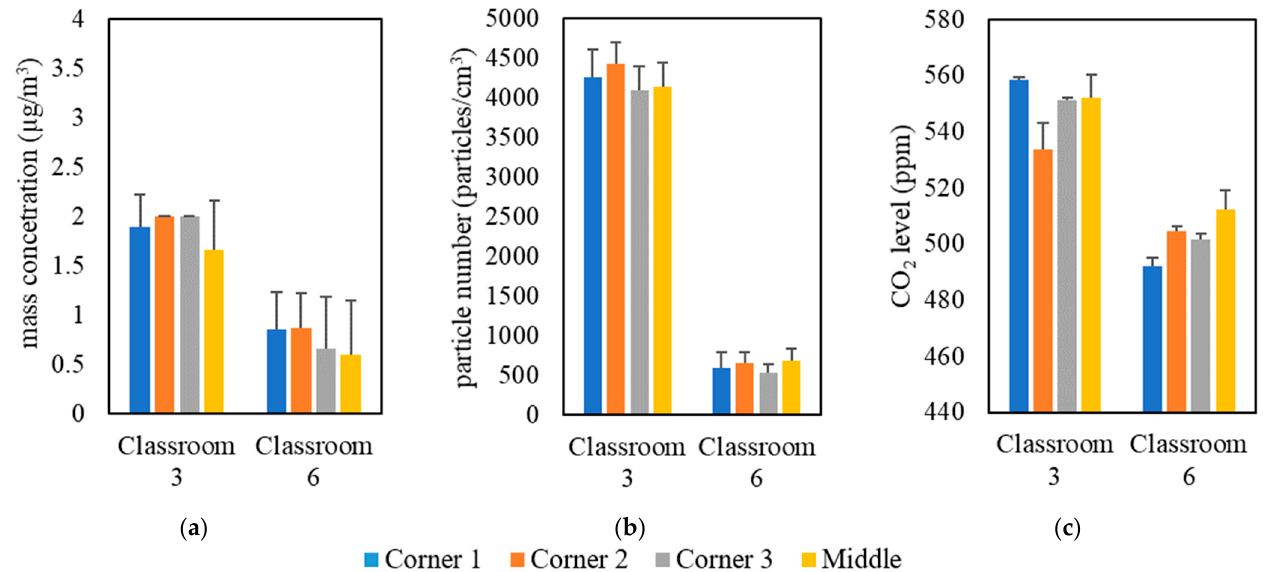
Figure 1. Spatial variability in classrooms 3 and 6 based on ( a ) PM, ( b ) PN, and ( c ) CO 2 . The error bars indicate standard deviations of values measured in a single day.